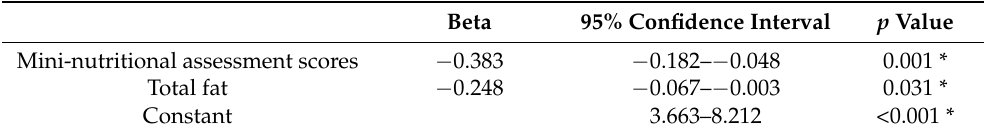
Table 4. Multiple linear regression of predisposing factors for the trajectory of cognitive decline in patients with AD receiving